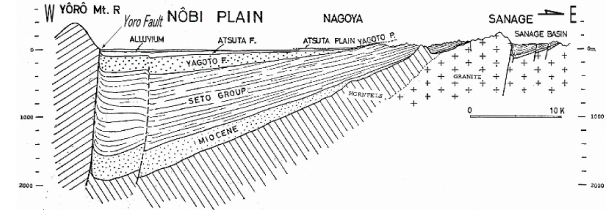
Figure 2. Quaternary block faulting and geologic profile of the No- hbi Plain (Kuwahara, 1968).